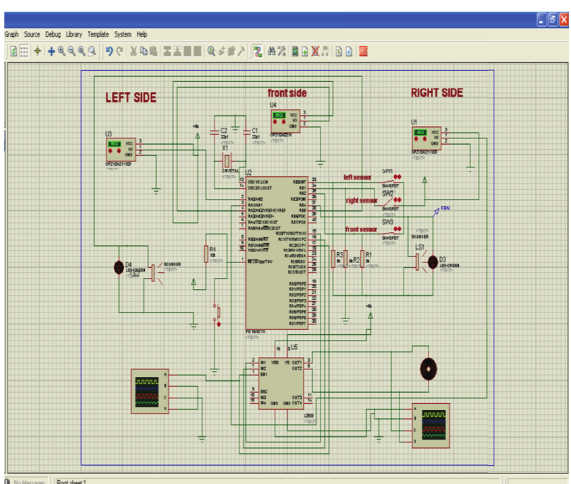
Figure 1: The whole circuit design using Proteus